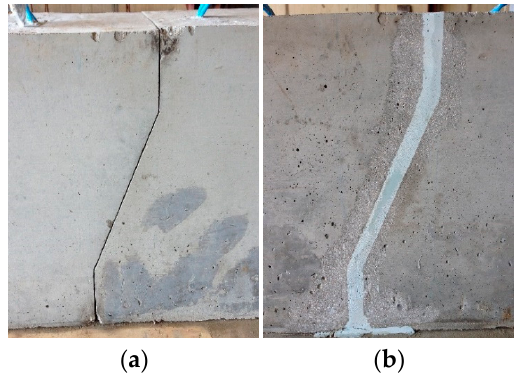
Figure 11. Shear key connection; ( a ) P-series; and ( b ) EP-series.